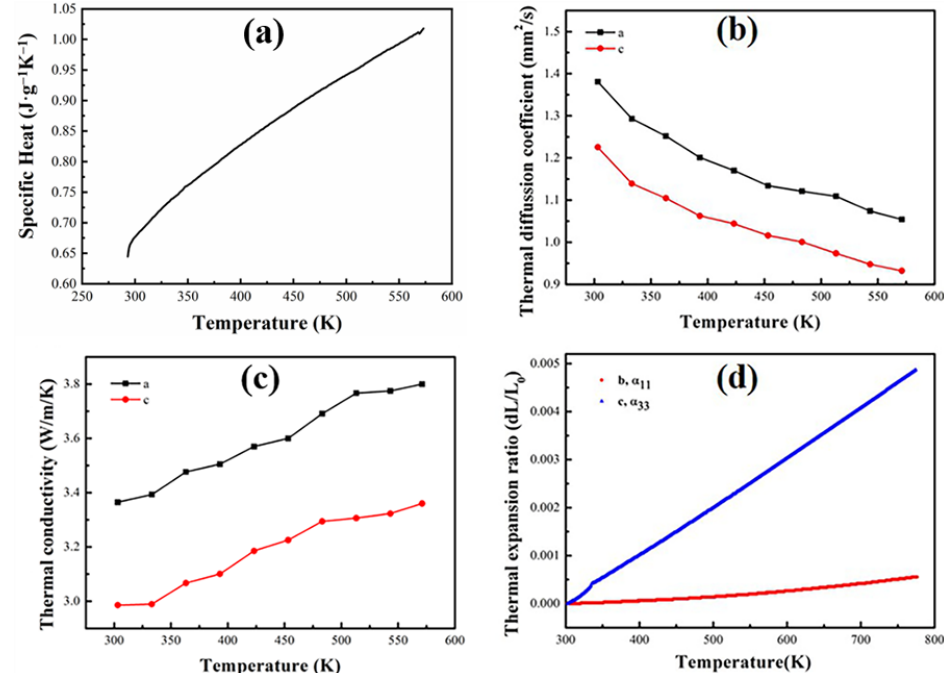
Figure 3. Thermal characteristics of Yb 3+ :ScBO 3 as a function of temperature: ( a ) specific heat, ( b ) thermal diffusion coefficient, ( c ) thermal conductivity with temperature, and ( d ) thermal expansion coefficient [34].